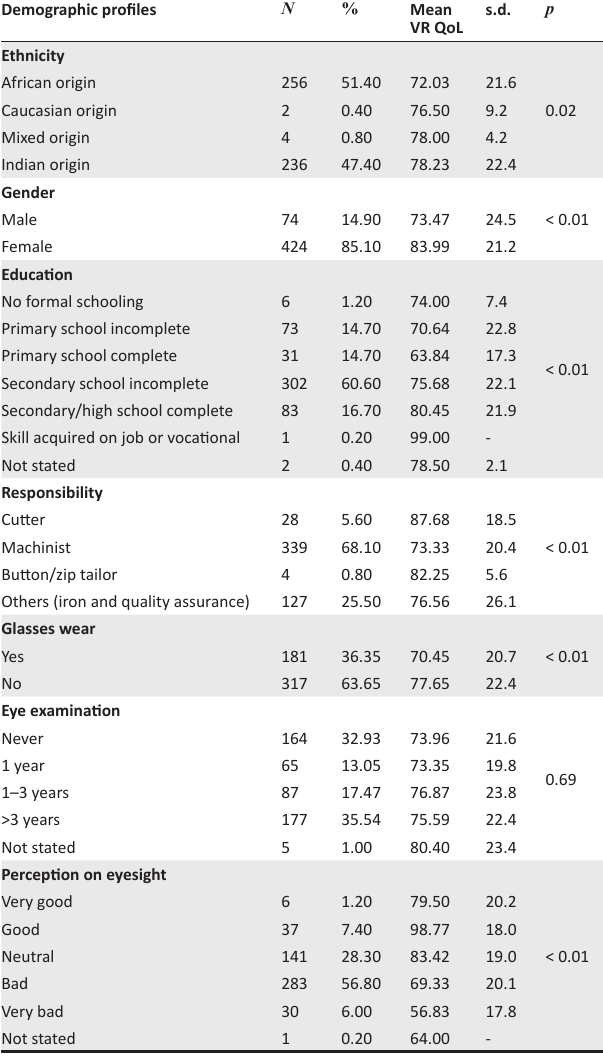
TABLE 1: Pre-treatment mean vision-related quality of life score of the 498 participants. Demographic